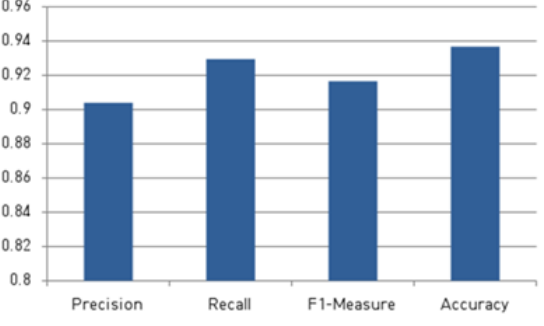
Figure 7. Results of merge